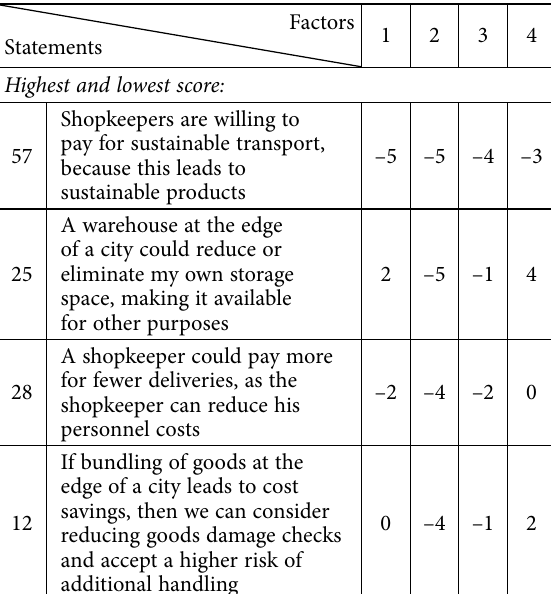
Table 5. Q-sort values for statements and